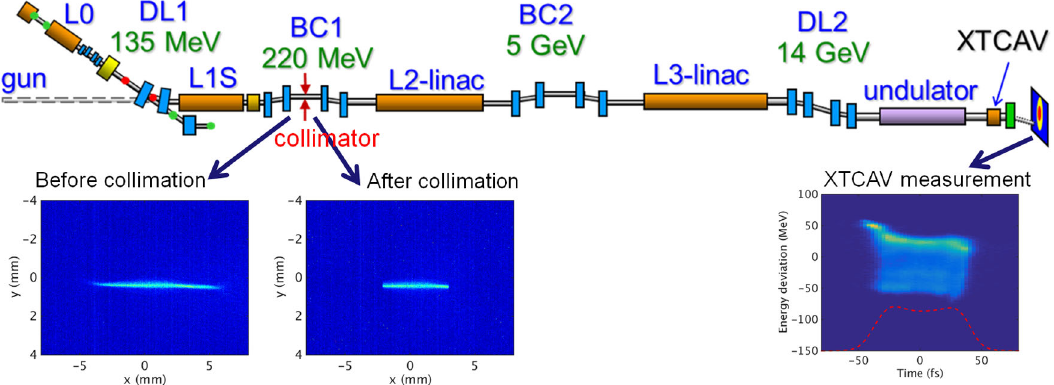
FIG. 1. A schematic of the LCLS machine layout including a collimator in the middle of the first bunch compressor (BC1) and the XTCAV downstream of the FEL undulator. The L2 and L3 are S-band rf linac sections. We also show the measured images at the middle of the BC1, before and after collimation, and a measured example from XTCAV for the collimated beam after FEL